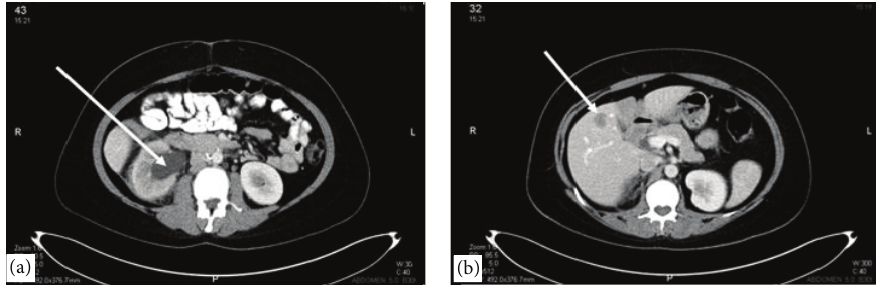
Figure 2: Computerized tomography showing severe hydroureteronephrosis on right side (a) and one of the hepatic metastases